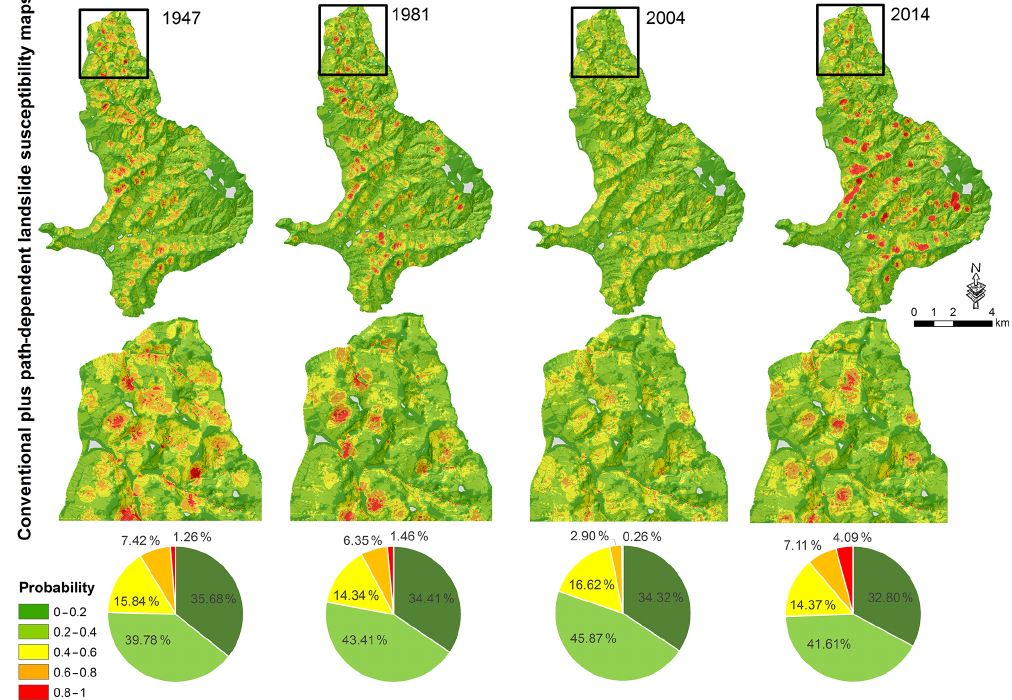
Figure 9. Examples of four dynamic conventional plus path-dependent landslide susceptibility maps in the years 1947, 1981, 2004 and 2014. Zoomed maps show the places where there are large changes in susceptibility over time.